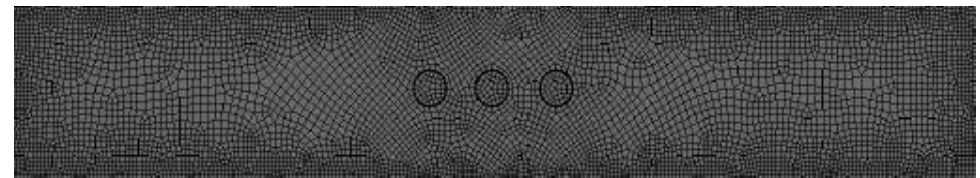
Figure 2. A view showing the numerical grid for power cable temperature estimation.